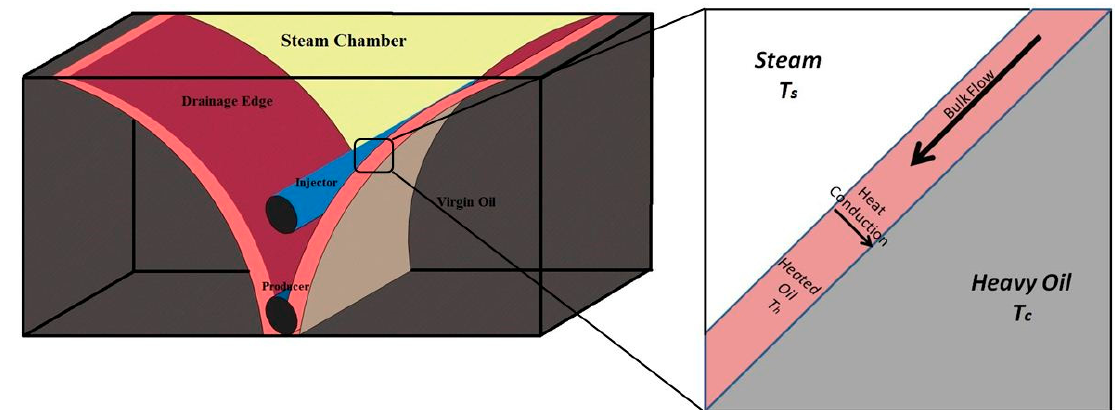
Figure 1. A simple schematic of the Steam-assisted gravity drainage (SAGD) process [5]. Reproduced with permission from (Sabeti et al.), (Journal of Petroleum Science and Engineering); published by (Elsevier), (2016).